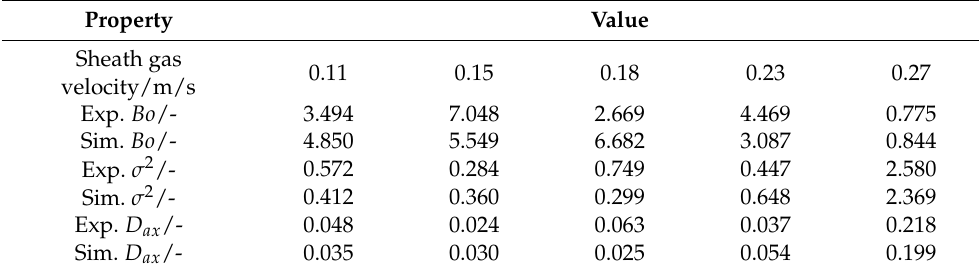
Table 5. Experimental and numerical Bodenstein numbers ( Bo ), variances ( σ 2 ), and axial dispersion coefficient ( D ax ) under different operating